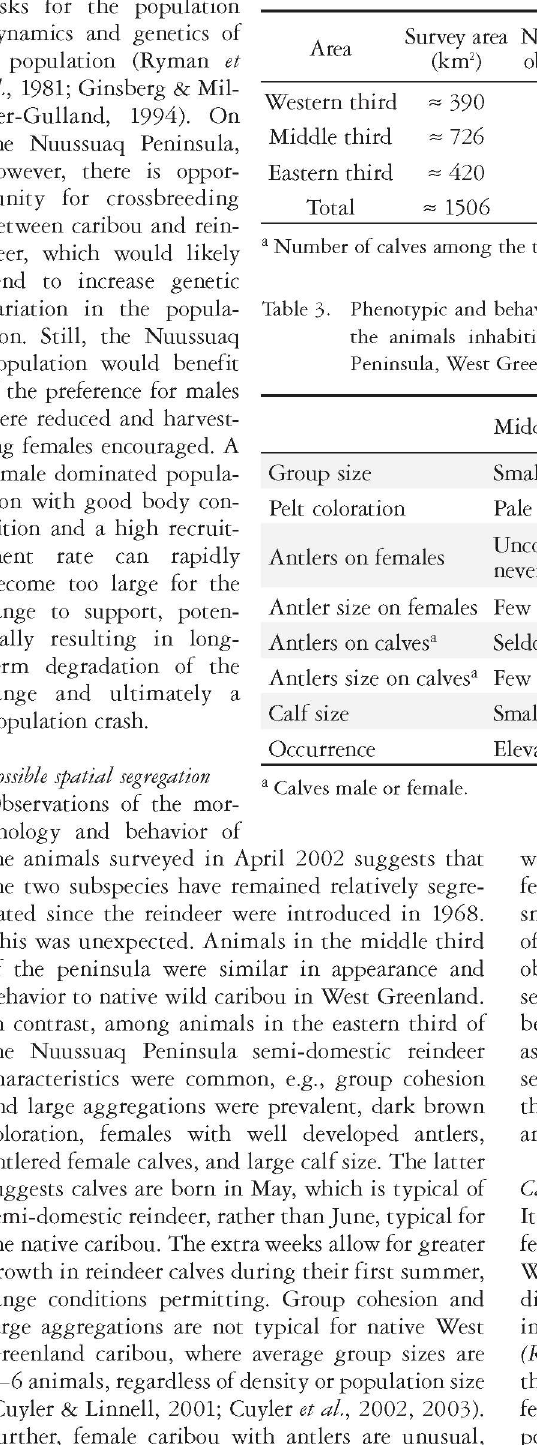
Table 3. Phenotypic and behavioral differences in Rangifer tarandus observed between the animals inhabiting the middle and eastern third's of the